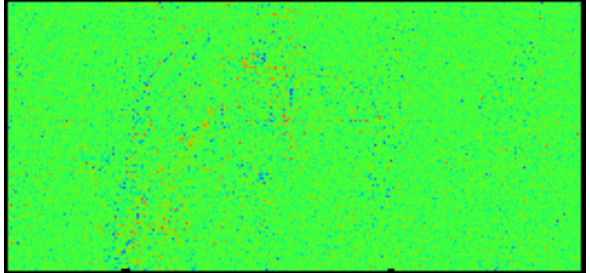
Figure 11: Radargrammetric control map for the Raw DEM ex- perimentally